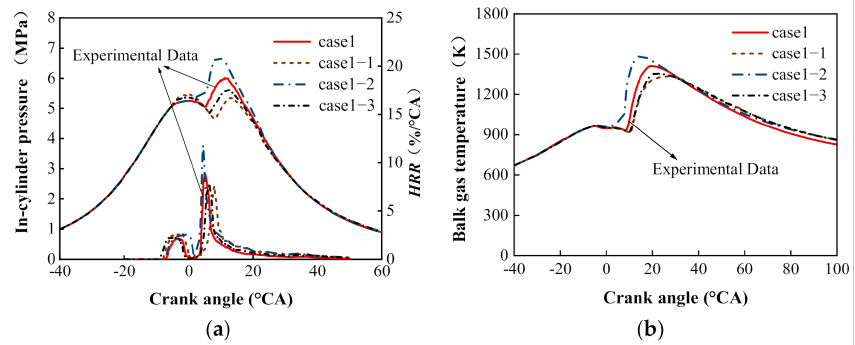
Figure 9. Characteristic of heat release: ( a ) pressure and HRR ; ( b ) bulk gas